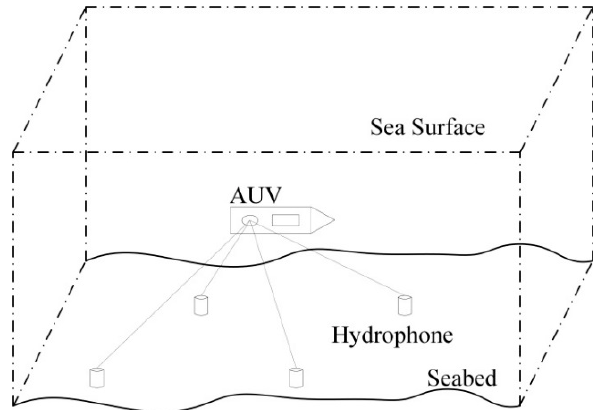
Figure 3. Schematic diagram of AUV underwater LBL positioning.